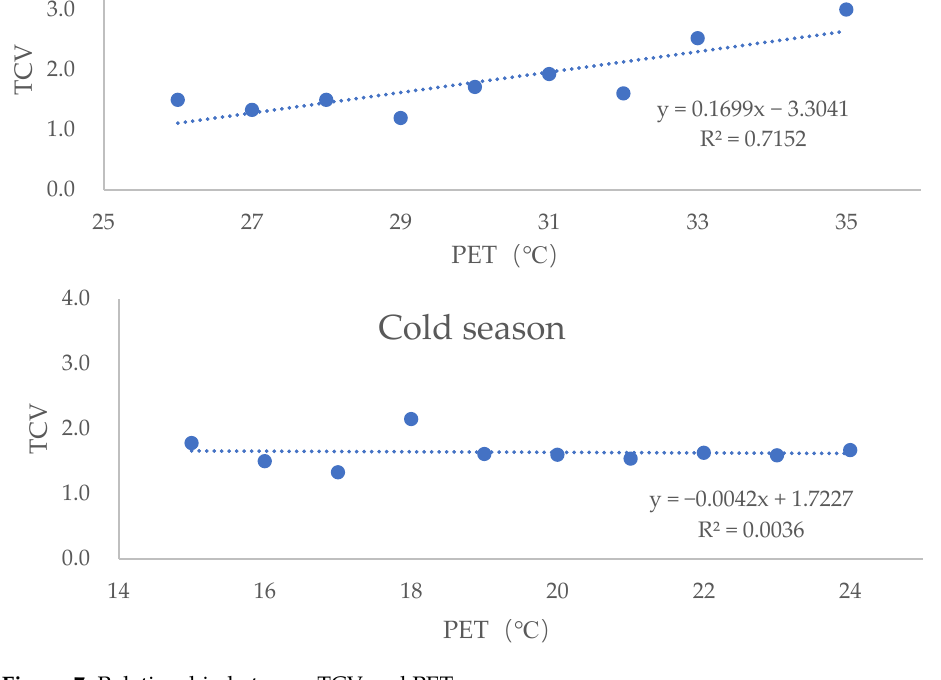
Figure 7. Relationship between TCV and PET.